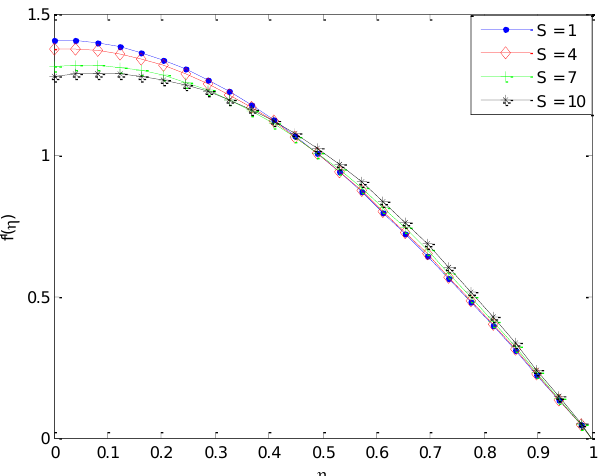
Fig. 5. Effects of Squeezing number on the flow velocity of the fluid.